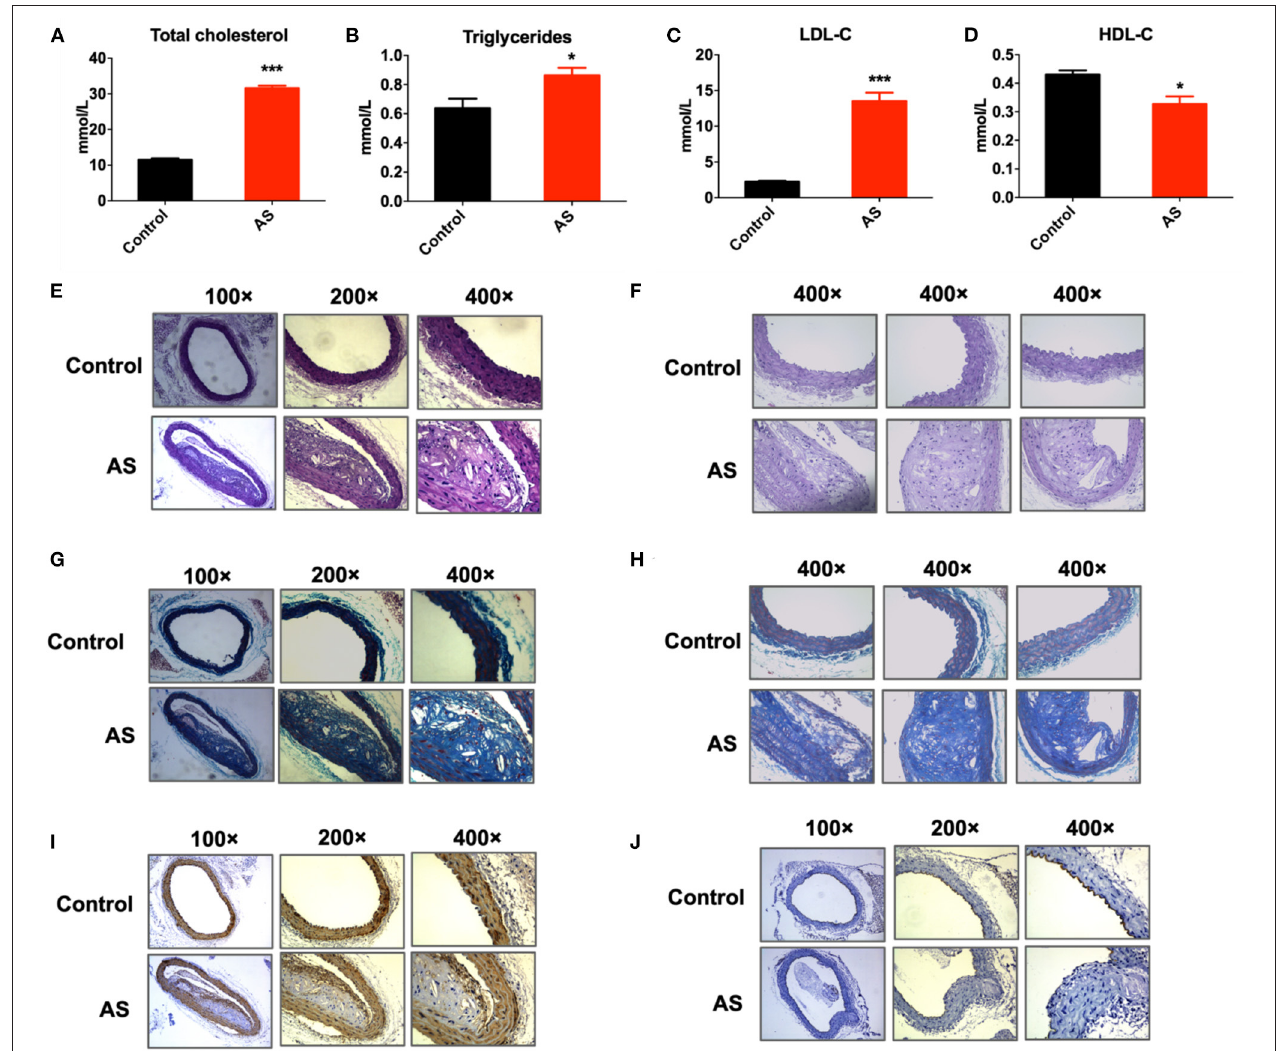
FIGURE 1 | Atherosclerosis mice model was established successfully. (A–C) Serum content of total cholesterol, triglycerides, LDL-C of ApoE-/- mice increased significantly after feeding with high fat diet for 12 weeks, * P < 0.05, *** P < 0.001 vs. control, n = 6. (D) Serum content of HDL-C of ApoE-/- mice decreased significantly after feeding with high fat diet for 12 weeks, * P < 0.05 vs. control, n = 6. (E,F) H & E staining of aortic arches of control and AS mice showed atherosclerotic plaques and foam cell aggregation in AS vessels. (G,H) Masson staining of aortic arches of control and AS mice. (I) Expression of α -SMA detected by immunohistochemical staining of aortic arches of control and AS mice. (J) Expression of CD31 detected by immunohistochemical staining of aortic arches of control and AS mice; n = 3.